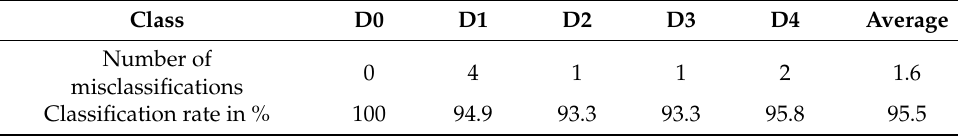
Table 3. Classification results for the test samples of Table 1.